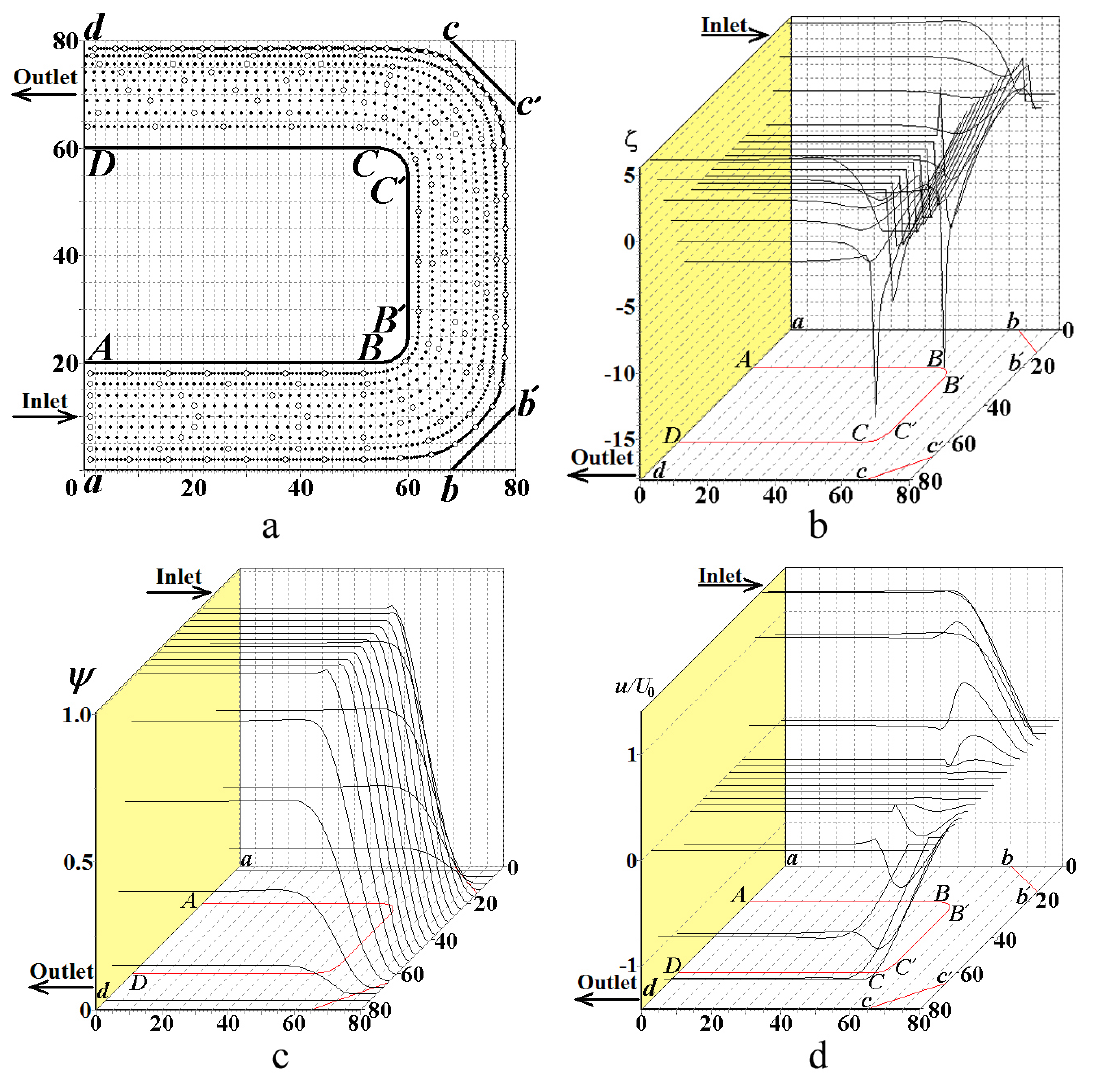
Fig. 3. CFD-derived flow lines (a), curl function ζ (b), flow function ψ (c), and dimensionless u-component of flow velocity w (d), derived for ECMAE of plasticine viscous fluid through the U-shaped slanted die abb’c’cd – ABB’C’CD, where the entrance (aA) and the exit (dD) are at the